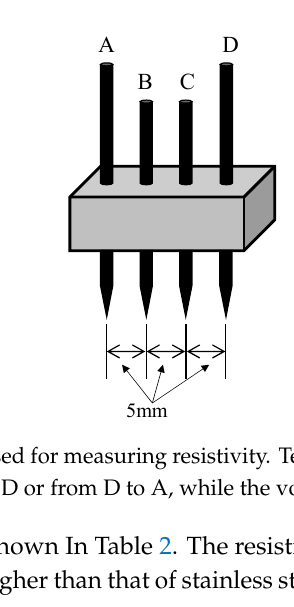
Table 2. Resistivities of woodceramics and